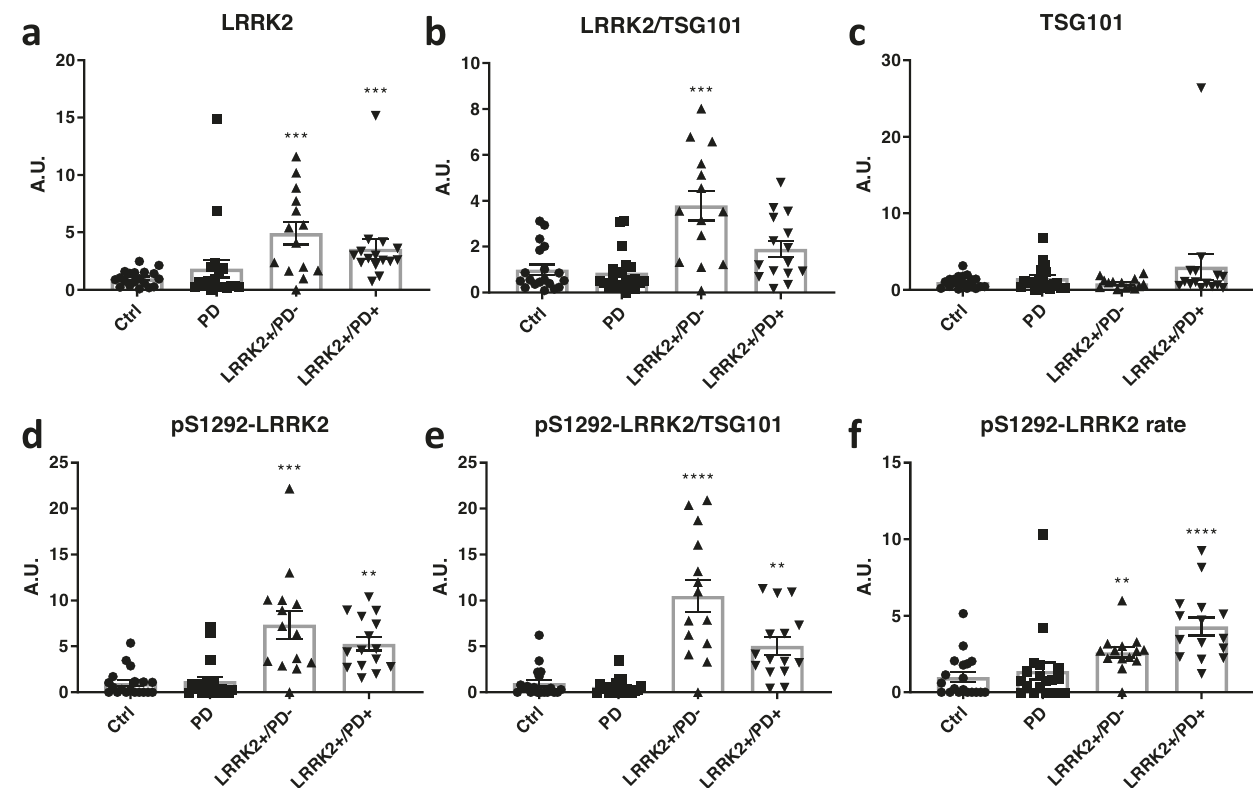
Fig. 2 LRRK2 and pS1292-LRRK2 in urinary EVs of iPD subjects and PD-manifesting and non-PD-manifesting LRRK2 carriers compared to healthy controls. Urine samples for this study were obtained from the LRRK2 cohort consortium as described in materials and methods, and the clinical characteristics of this cohort are given in Table 1. Urinary EVs were isolated for subjects ’ urine samples as described in materials and methods and total-LRRK2 ( a ), total LRRK2 normalized to TSG101 ( b ), TSG101 ( c ), pS1292-LRRK2 ( d ), pS1292-LRRK2 normalized to TSG101 ( e ) and the rate of LRRK2 phosphorylation at S1292 ( f ) were determined using western blotting (quadruplicate measures per sample). Direct values and ratios of values were normalized to the ‘ pool ’ calibrator (Supplementary Fig. 1). Note that the values of phosphorylation ‘ rate ’ are indicative of the proportion of protein that is phosphorylated at the given site, see materials and methods. Results are depicted here in the form of histograms. Signi fi cant differences were tested via the Kruskal-Wallis test, using the healthy control group as control. Error bars represent standard error of the mean (s.e.m.). * P < 0,05; ** P < 0,01, *** P < 0,001, *** P < could be detected in human urinary EVs, with a detection limit of recombinant Rab8a close to 20 ng/ml (Supplementary Fig. 5). A representative image of the blots that were used for quanti fi cation, illustrating the multiple epitopes detected on the same samples, is given in Supplementary Fig. 7. Statistical signi fi cance was fi rst tested for the full groups of healthy controls (HC) compared to idiopathic PD patients and subsequently the same comparisons were performed separately for males and females. We observed that there is a signi fi cant difference between the healthy control compared to idiopathic PD groups for total Rab8 and total TSG101 (upregulation) and for the S910-LRRK2 and S935- LRRK2 phosphorylation rates (downregulation) (Fig. 3). Receiver operator characteristic analysis for these 4 parameters yielded areas under the curve ranging from 0,6047 to 0,6925 (Supplemen- tary Fig. 8). We noted 2 subjects displaying strong outlying values for Rab8 and 1 of these 2 also displaying a strong outlier for TSG101 levels (Fig. 3B, C). Upon review of the clinical characteristics of these 2 subjects, we did not fi nd a speci fi c explanation for this, as we observed typical PD without red fl ags and without speci fi c kidney or in fl ammatory conditions, suggesting that these outliers are an aspect of normal variability of these. Note also that the exclusion of these 2 values did not alter the statistical conclusion of the signi fi cant increase of Rab8 and TSG101 in PD. For markers related to LRRK2 kinase activity, including S1292-LRRK2 phosphor- ylation rate and T72-Rab8 phosphorylation rate, no signi fi cant differences were observed between HC and iPD groups. It is also